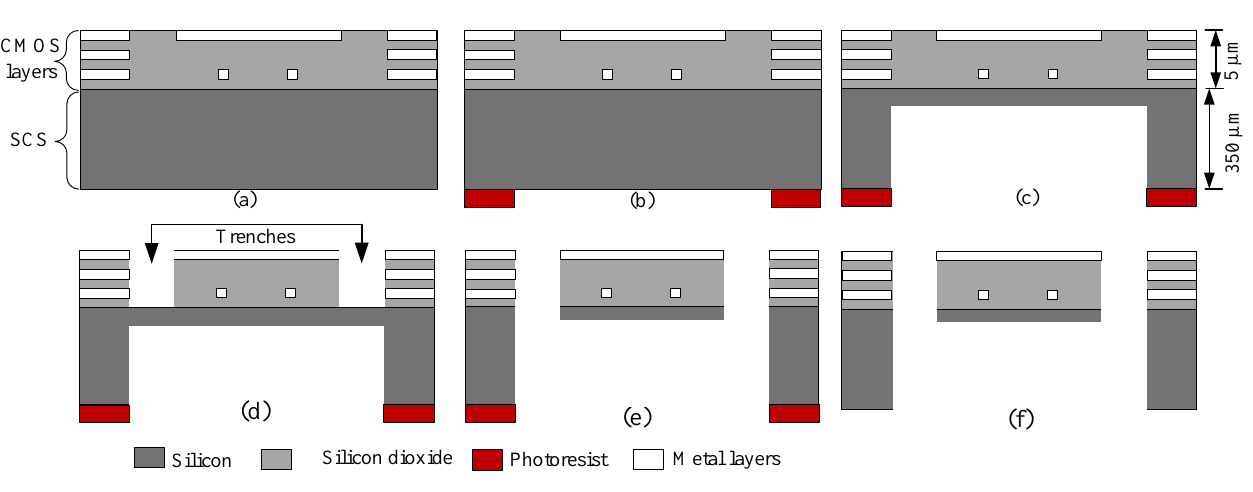
Figure 2. Schematic cross-sectional view of ( a ) Back grind; ( b ) PR layer deposited; ( c ) Anisotropic etching of Si from backside; ( d ) Anisotropic etching of SiO 2 from front side; ( e ) Isotropic etching of Si from front side; ( f ) Released device with photoresist mask